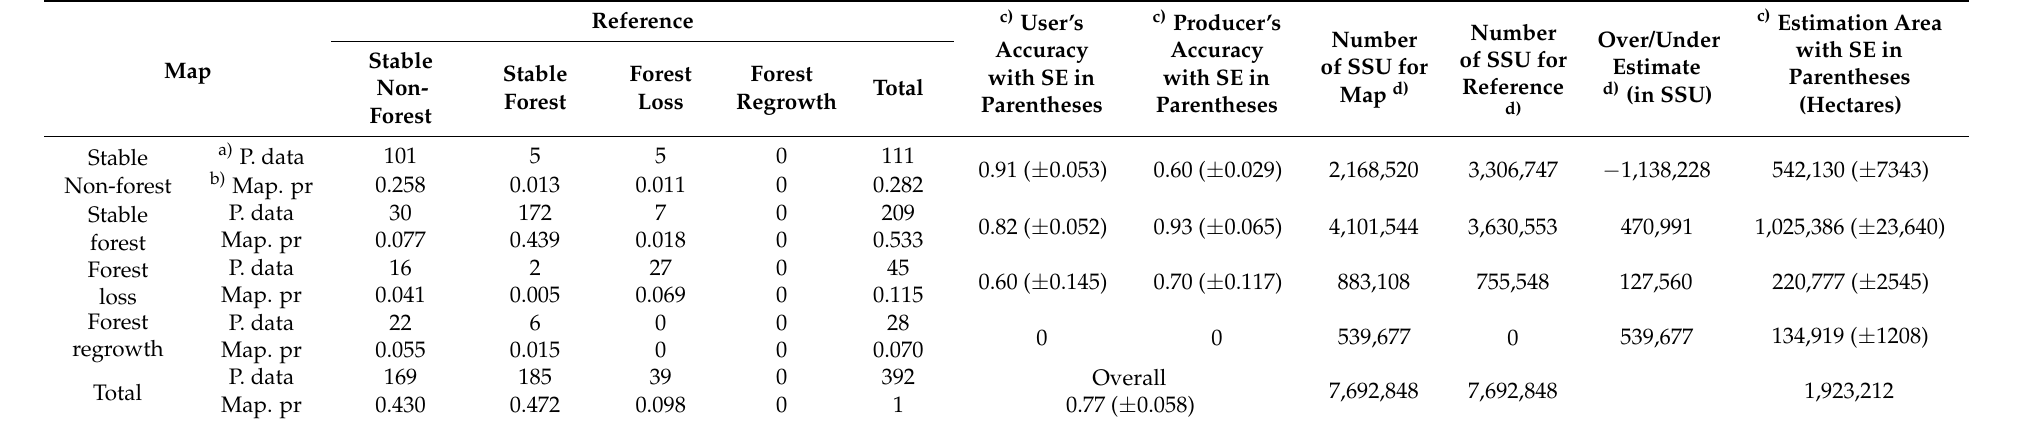
Table A3. Description of population data and map proportion area confusion matrix for the automated digital processing of land cover change map in 2006–2012.